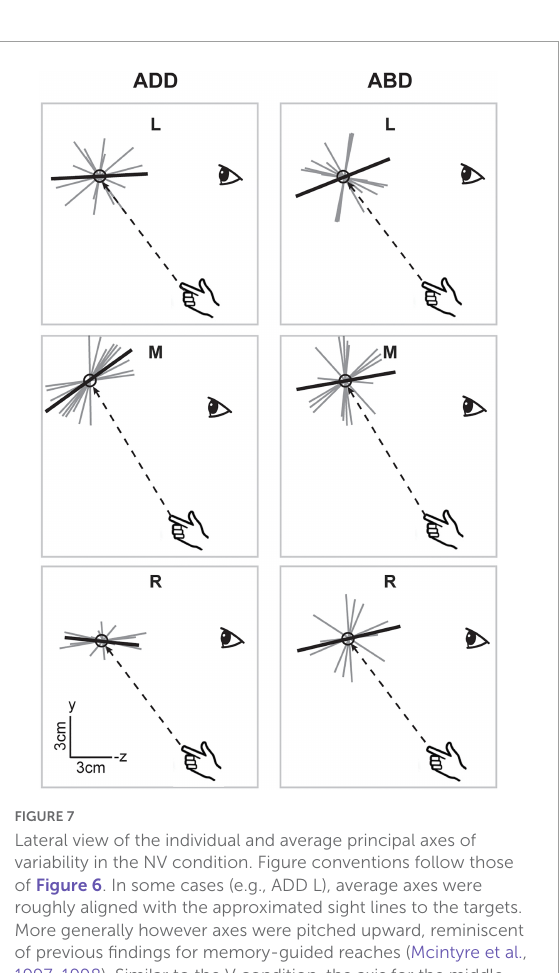
FIGURE6 Lateral view of the individual (gray) and average (black) principal axes of variability in the V condition. Dashed lines show the straight-line paths to each target. Average axes were generally aligned along subjects’ approximated sight lines to the targets. Apparent effects of posture were only observed for the middle target and manifested as a downward rotation as posture changed from ADD to ABD.